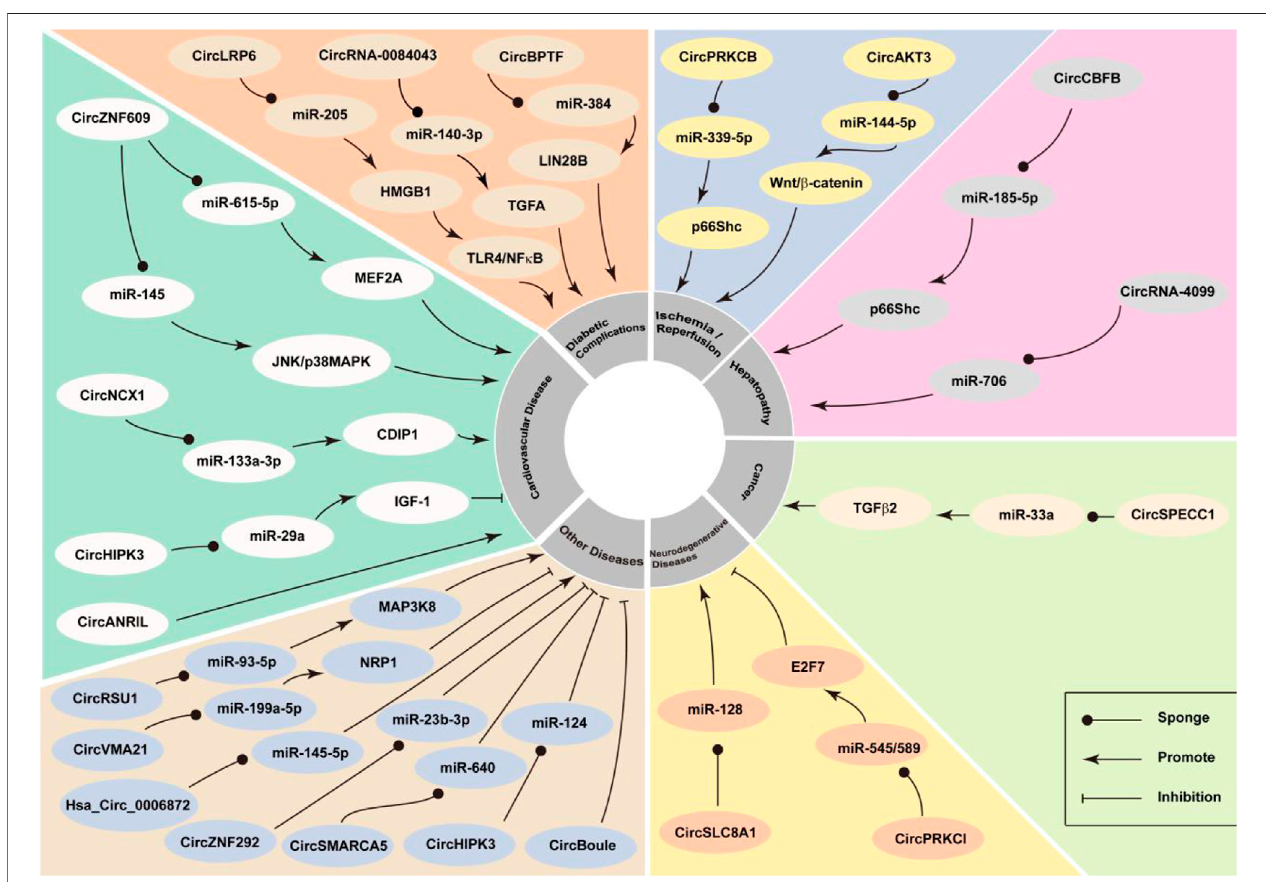
FIGURE 2 | CircRNA participates in oxidative stress and has the effect of increased oxidative stress or anti-oxidation, leading to the development or inhibition of oxidative stress-related diseases.